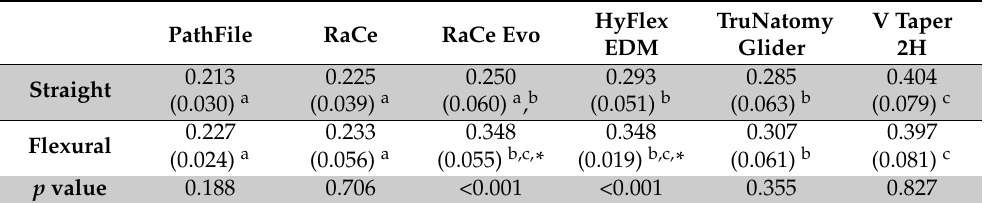
Table 2. Instrument’s ultimate strength (N cm) from torsional fracture resistance testing in straight and flexural mode shown as mean (standard deviation). PathFile